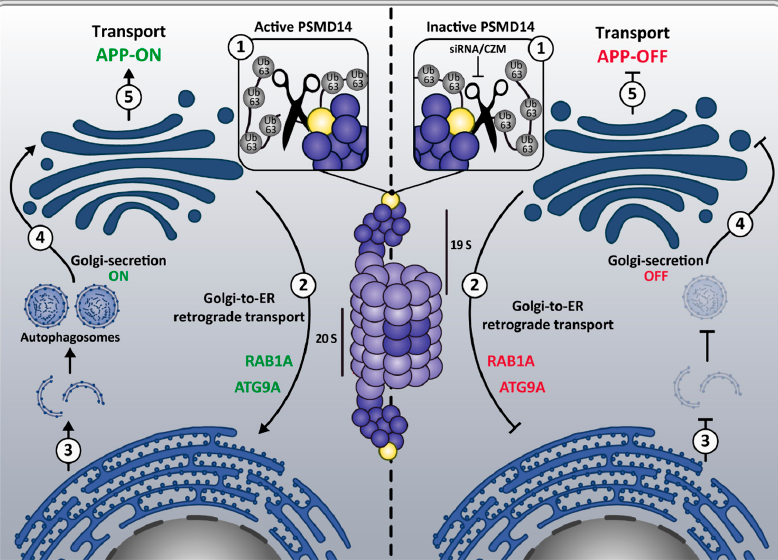
Figure 8. Model of the mechanism underlying the regulation of protein membrane tra ffi cking and macroautophagy by the proteasome 19S RP PSMD14 DUB activity. The model depicts the closed interplay between membrane transport and macroautophagy by a novel mechanism involving the proteasome complex through the deubiquitinating activity of PSMD14. We propose that active PSMD14 and the K63-Ub chains ( 1 , left panel) positively regulate Golgi-to-ER retrograde transport ( 2 , left panel), a pathway implicated in the retrieval of key proteins for autophagosome biogenesis and macroautophagy ( 3 , left panel). Reduction of free K63-Ub chains by inactive PSMD14 ( 1 , right panel) results on the blockage of Golgi-to-ER retrograde transport ( 2 , right panel) causing the accumulation of ATG9A and RAB1A at the Golgi apparatus. Thus, blockage of Golgi-to-ER retrograde transport inhibits the biogenesis of autophagosomes and macroautophagy ( 3 , right panel). Macroautophagy has been recently demonstrated to act as a potent positive regulator of protein transport from the Golgi apparatus to the cell surface (Golgi-secretion ON; 4 , left panel). Thus, inhibition of macroautophagy upon inactive PSMD14 (siRNA / CZM) blocks protein transport from the Golgi apparatus to the cell surface (Golgi-secretion OFF; 4 right panel), explaining the effect on APP transport ( 5 left and 5 right